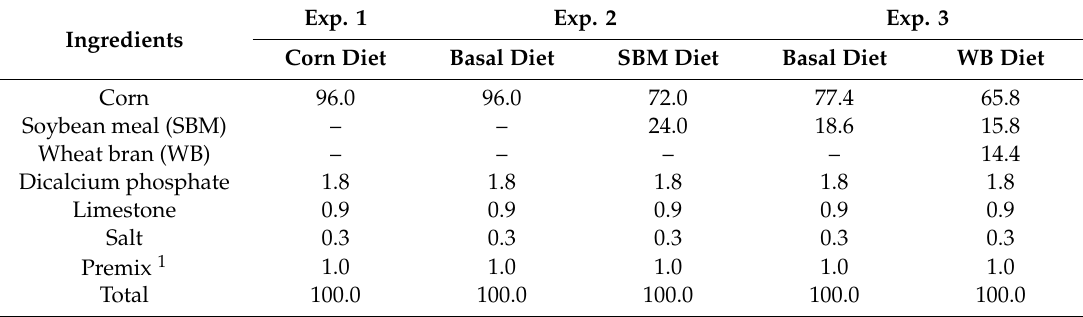
Table 2. Ingredient composition of the experimental (Exp.) diets (% as fed